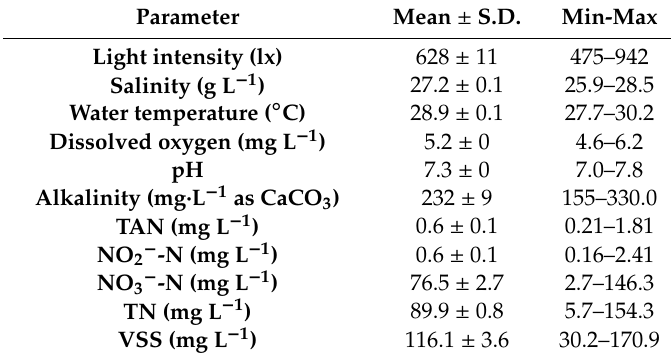
Table 2. Mean and range values of the monitored water environmental parameters in the shrimp culture tanks of the biofloc-based recirculating aquaculture system (biofloc-RAS) during a 70-day trial (mean ± S.D., N =